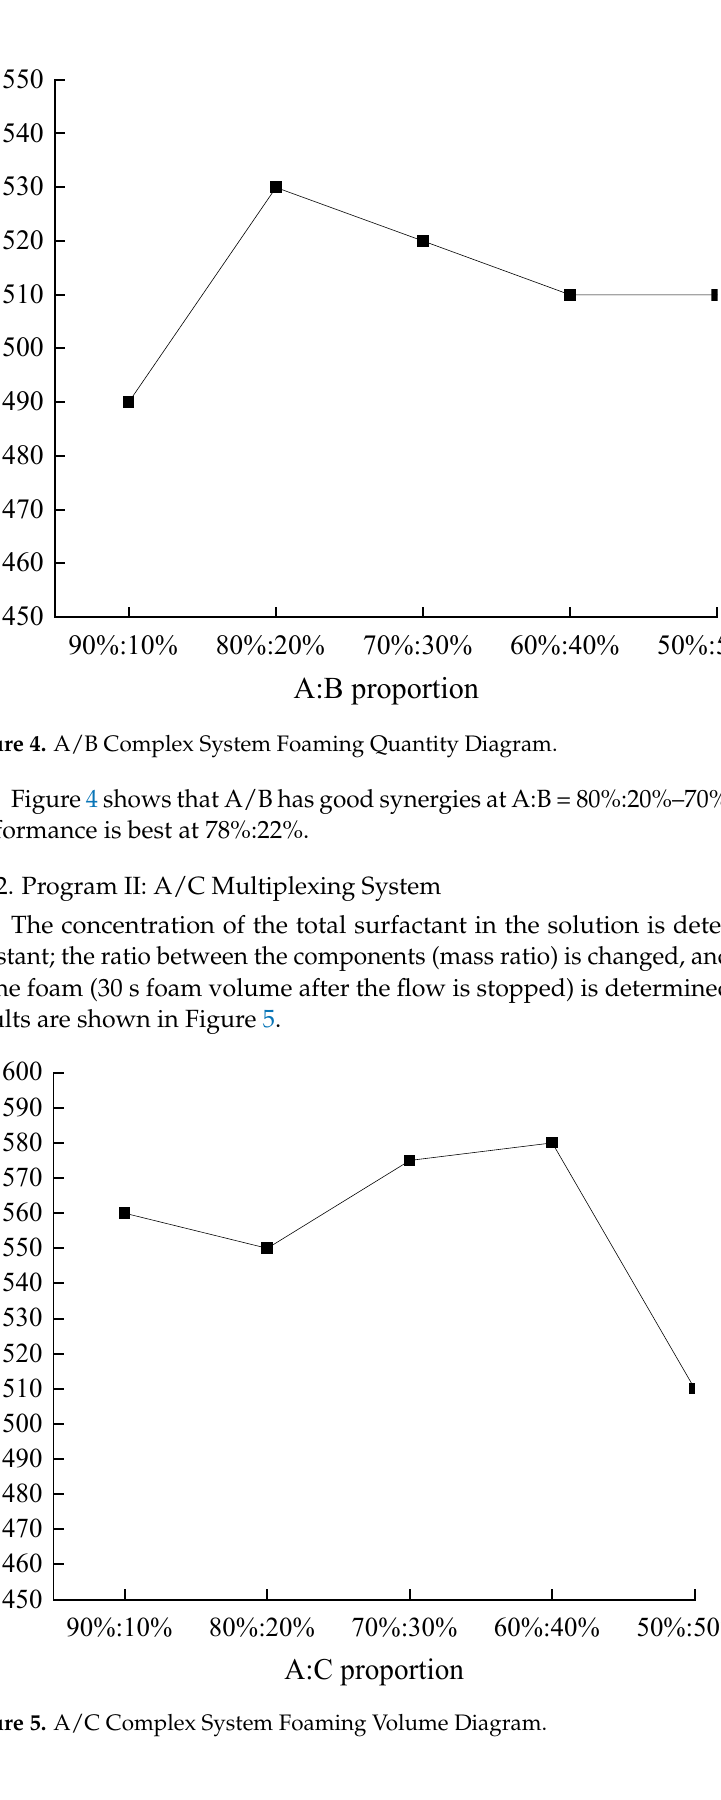
A:D proportion Figure 6. A/D Blister Volume Diagram. As you can see from Figure 6, foaming is best when A:D = 83%:17% (approximately 5:1). Studies [38,39] suggest that hydrogen bonding between non-ionic surfactants and protons in water shows the properties of weak cationic surfactants. This has some electri- cal attractiveness with the molecular polar head of the anionic surfactant, making